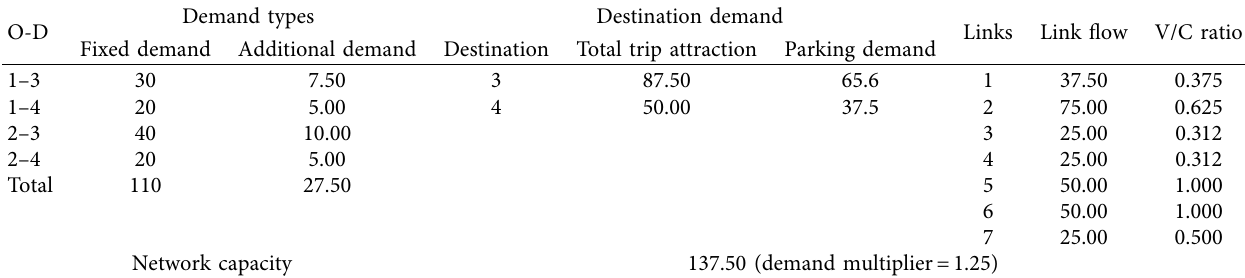
Table 4: Results of the reserve network capacity model.